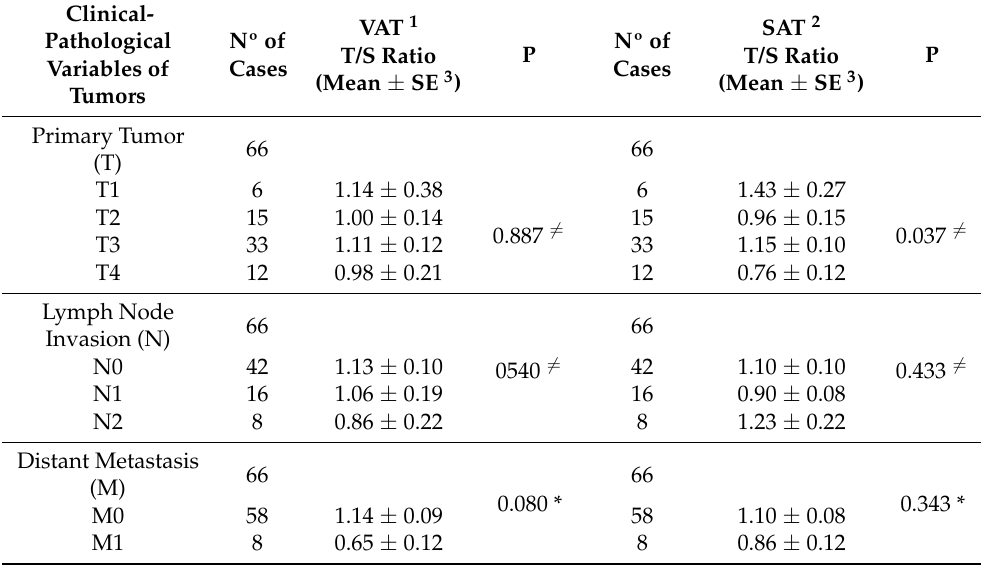
Table 3. Telomere length, measured as T/S ratio, in visceral and subcutaneous adipose tissues from colorectal cancer patients, in relation to the clinical-pathological variables of the tumors. Clinical- Pathological Variables